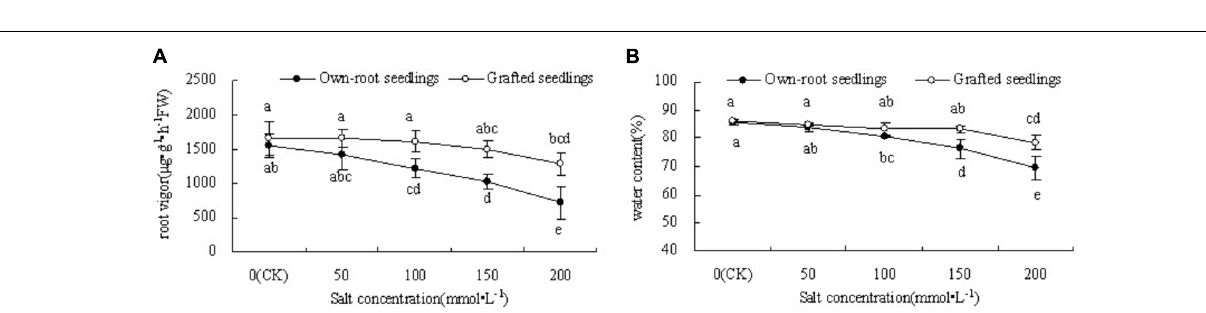
FIGURE 2 | Root vigor (A) and leaf water content (B) of mulberry own-root seedlings and grafted seedlings under salt